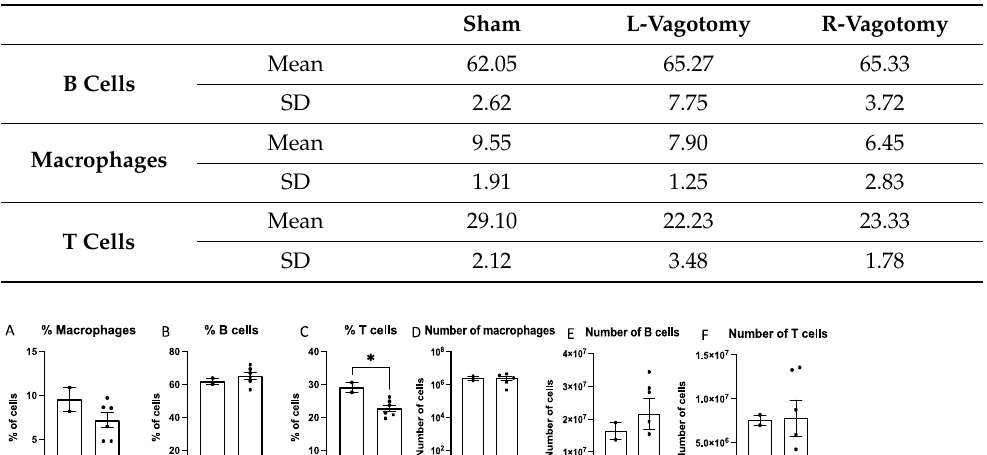
Table 1. Vagotomy alters the splenic immune profile following either right or left vagotomy. Quan- tification of flow cytometric analysis of the number of macrophages (CD11b+CD3 − CD19 − ), B cells